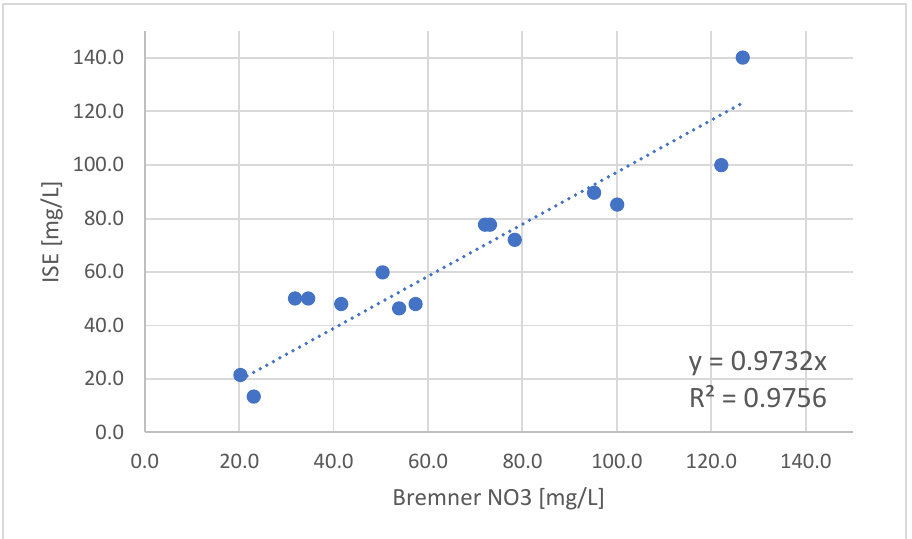
Figure 11. Comparison between the referent Bremner method and ISE method for nitrate-nitrogen detection.